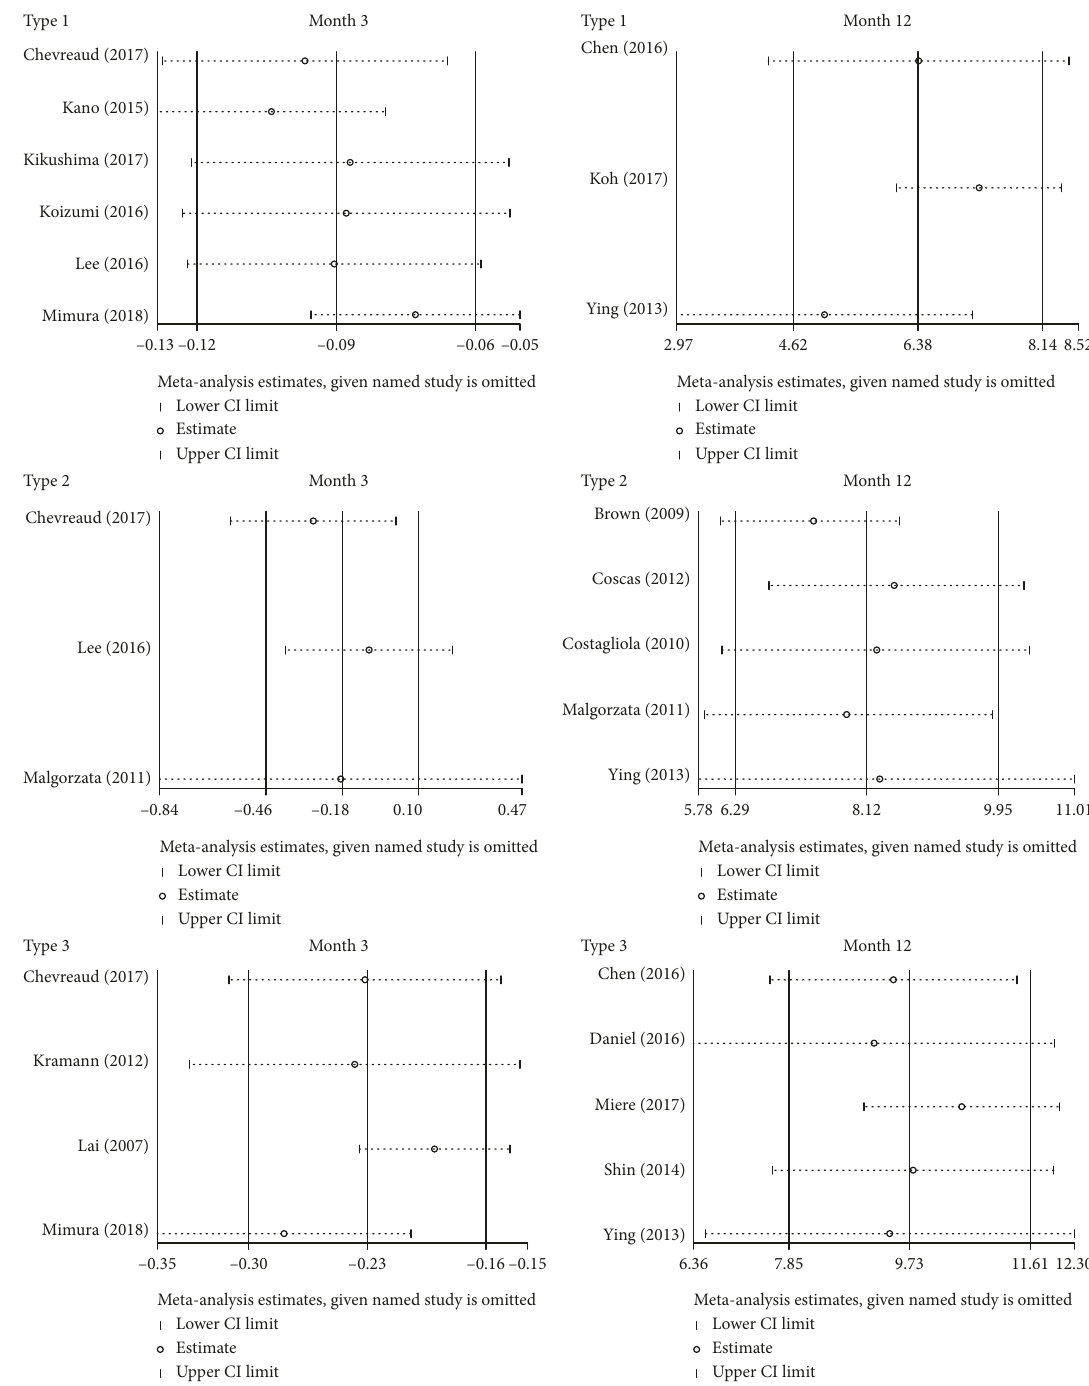
Figure 6: Sensitivity analysis on the outcome of vision improvement at 3 and 12